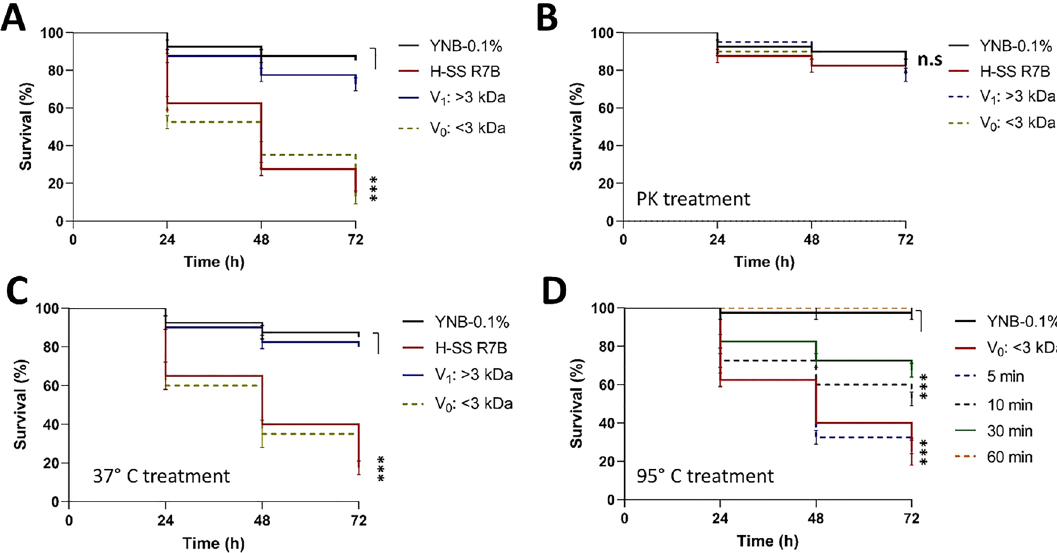
Figure 2. The toxic factor in the cell-free supernatant of the culture (SS) of M. lusitanicus was susceptible to protease activity and had a low molecular weight. ( A ) SS from the R7B strain obtained under aerobic conditions (H-SS) in YNB medium supplemented with 0.1% glucose (YNB-0.1%) after 48 h of growth was passed through a molecular weight exclusion filter (cut off 3 kDa), obtaining a V o fraction consisting of molecules with a weight lesser than 3 kDa and a V 1 fraction consisting of molecules with a weight greater than 3 kDa. ( B ) SS or V o and V 1 fractions from panel A were treated with proteinase K (PK) for 2 h at 37 °C; SS or V o and V 1 fractions from panel A were incubated for 2 h at ( C ) 37 °C or ( D ) 95 °C. All the SSs and fractions were used to treat Caenorhabditis elegans to test their toxicity. A total of 15–20 nematodes were used per experiment and incubated at 18 °C for 72 h. The results presented are the average of the values obtained from four independent experiments. The data were statistically analyzed using the Mantel-Cox test. *** P < 0.01. When results were considered not significant, we did not provide an additional indication ( P >